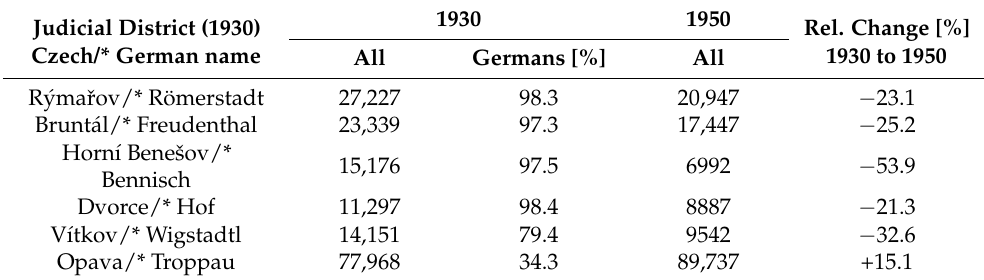
Table 1. The population in selected former judicial districts between 1930 and